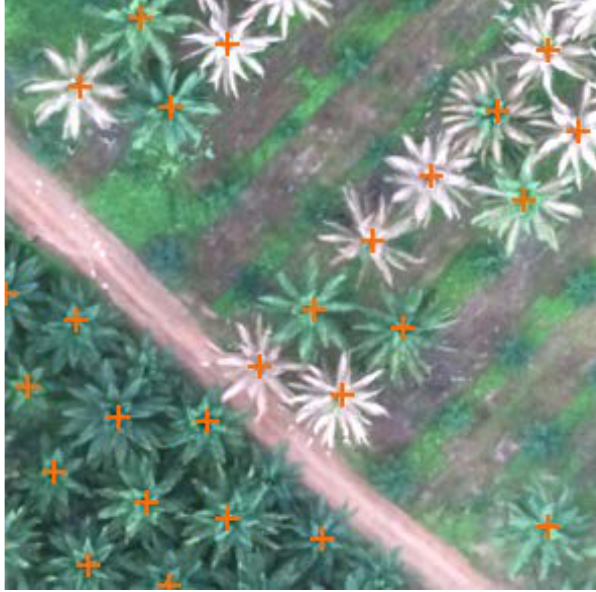
Figure 6: Results of tree detection (orange crosses) using a template matching algorithm that was populated with templates of oil palm